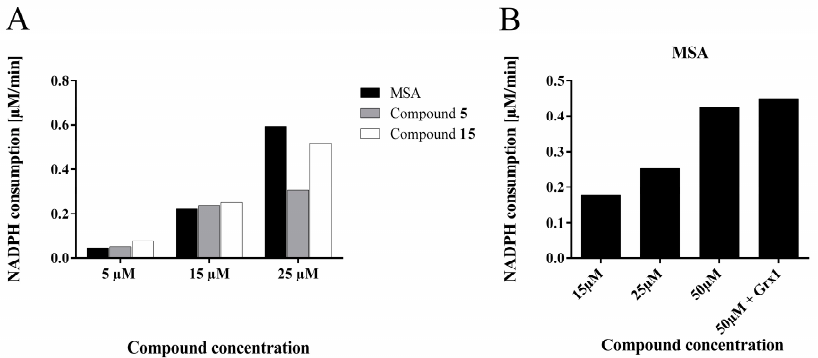
Figure 7. Compounds 5 and 15 are substrates for thioredoxin reductase but not for the glutathione- glutaredoxin system. ( A ) NADPH consumption indicating reduction of compounds 5 , 15 or MSA as control by thioredoxin reductase. The reaction mixture contained 100 nM TrxR1, 227 μ M NADPH and the corresponding amount of compound in TE buffer (20 mM Tris, 2 mM EDTA pH = 8); ( B ) NADPH consumption indicating reduction of MSA by glutathione in the presence or absence of glutaredoxin. The reaction mixture contained the corresponding amount of compound, 0.1 M Tris, 2 mM EDTA pH = 8, 0.1 mg/mL BSA, 1 mM GSH, 200 μ M NADPH, 0.008 OD/mL yeast GR and 1 μ M hGrx1 when required. Only results for MSA are shown, as compounds 5 and 15 were not reduced.